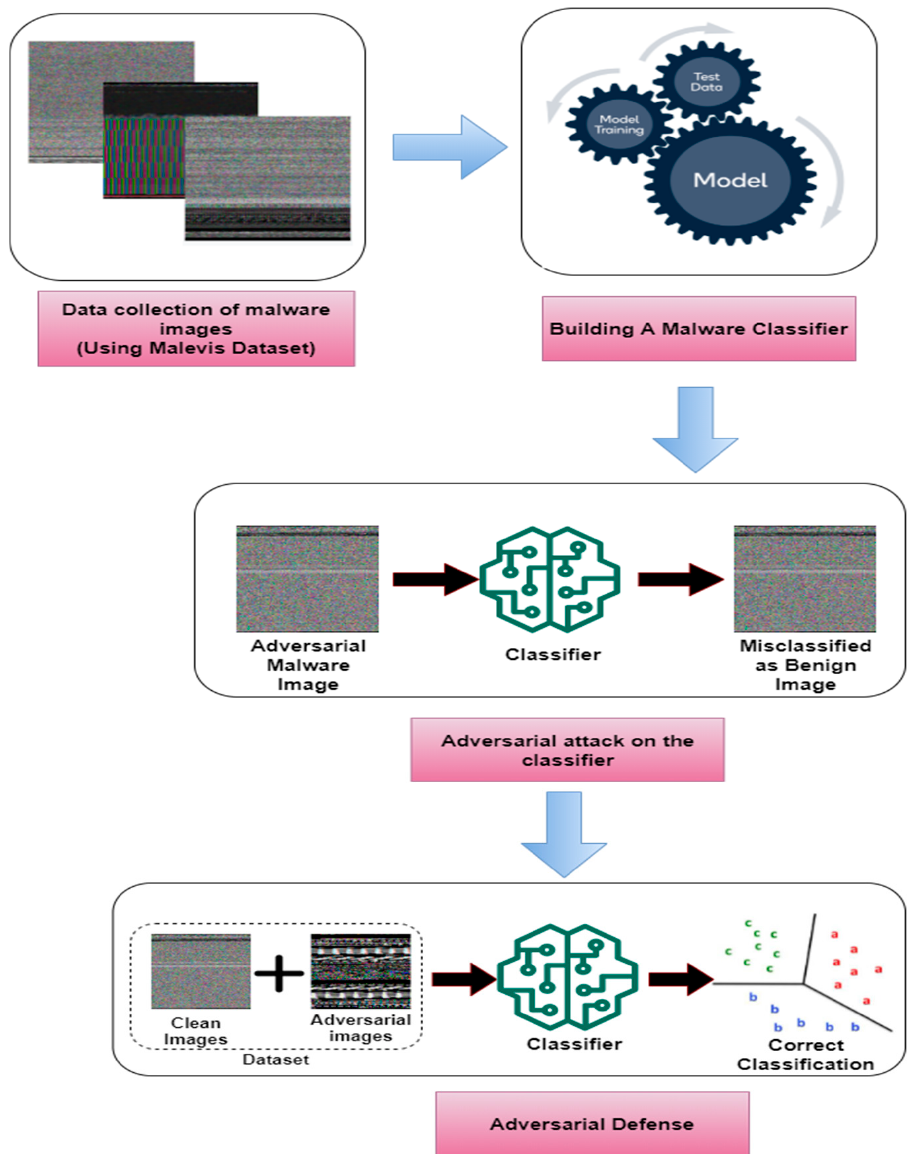
Figure 4. Schematic representation of the proposed model architecture.